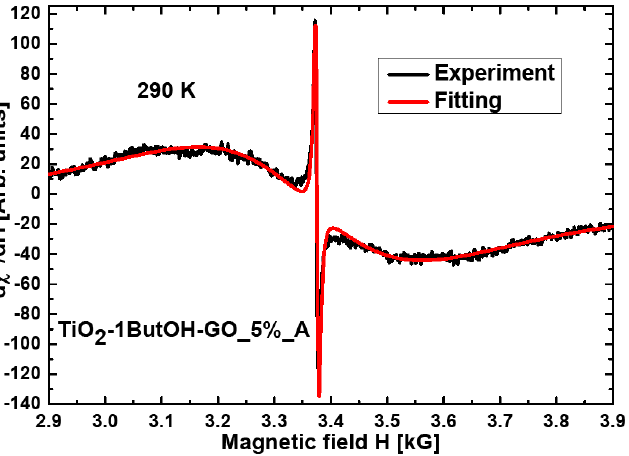
Figure 3. The fitting by the Lorentzian function obtained for the nanocomposite TiO 2 ‐ 1ButOH ‐ GO_5%_A.